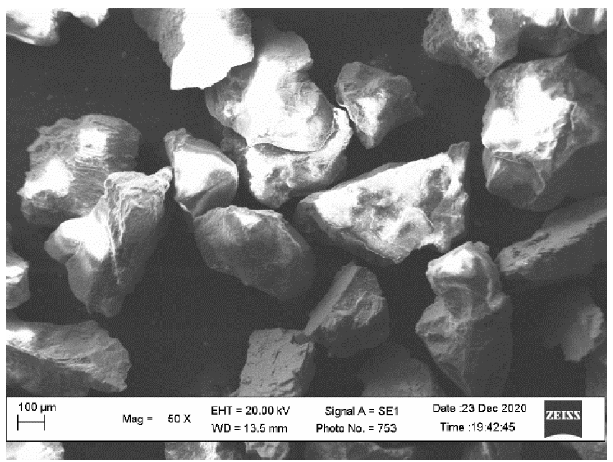
Figure 4. The results of the studies of the morphology of the SiO 2 abrasive particles.